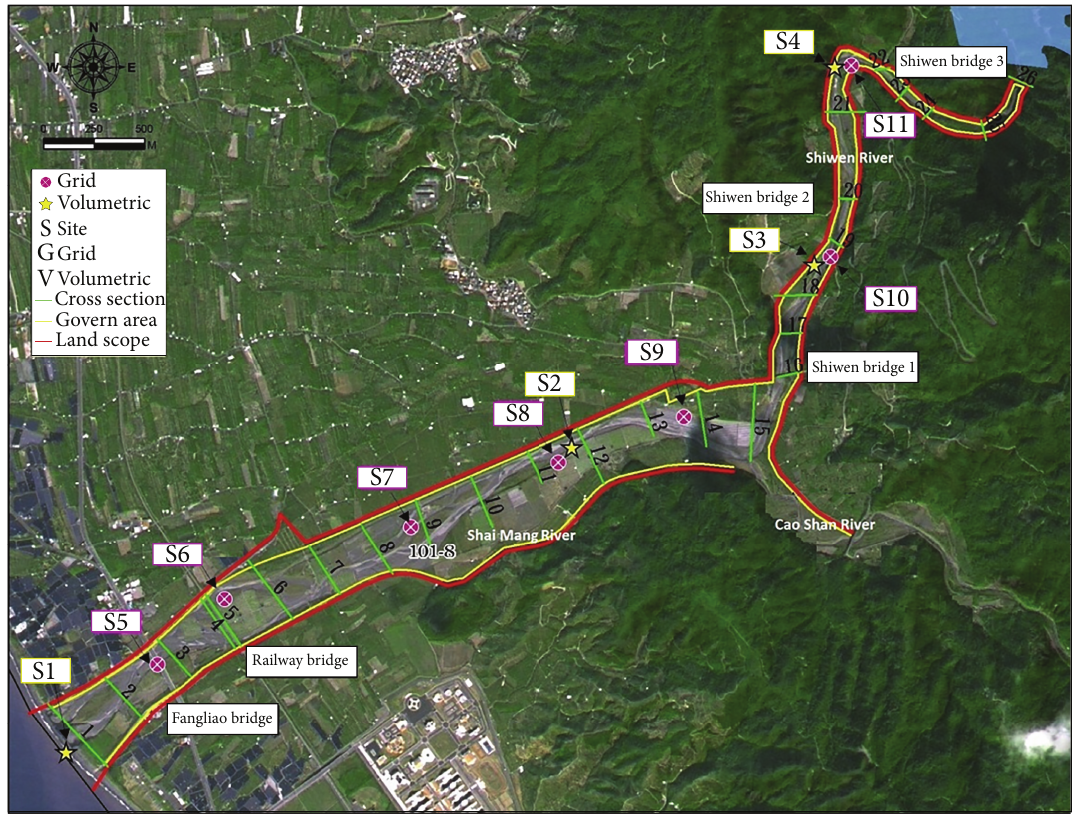
Figure 2: Sampling points